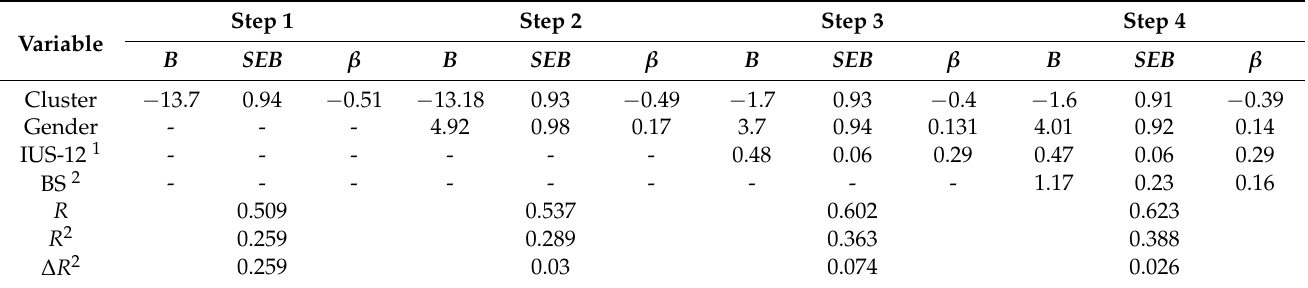
Table 3. Stepwise multiple linear regression analysis, with GSI-18 Index during the lockdown as a dependent